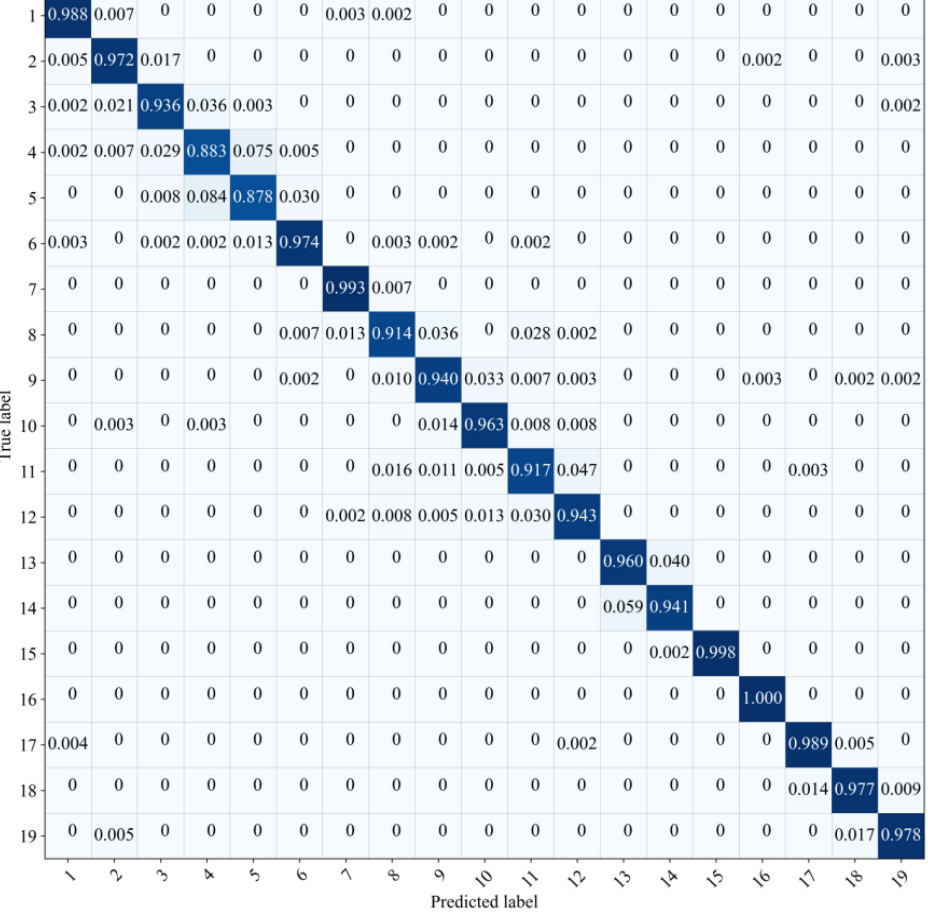
Figure 6. The confusion matrix of the results.